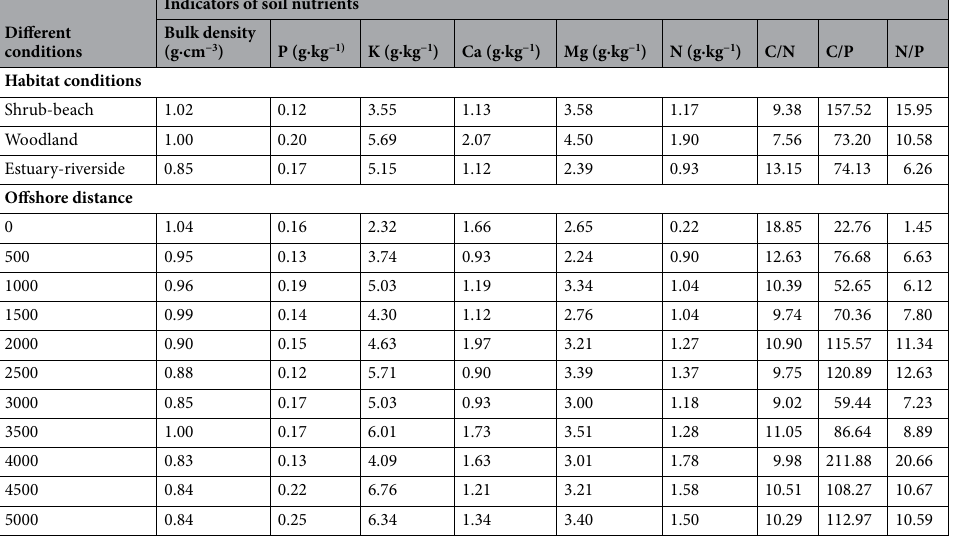
Table 2. Variation characteristics of soil